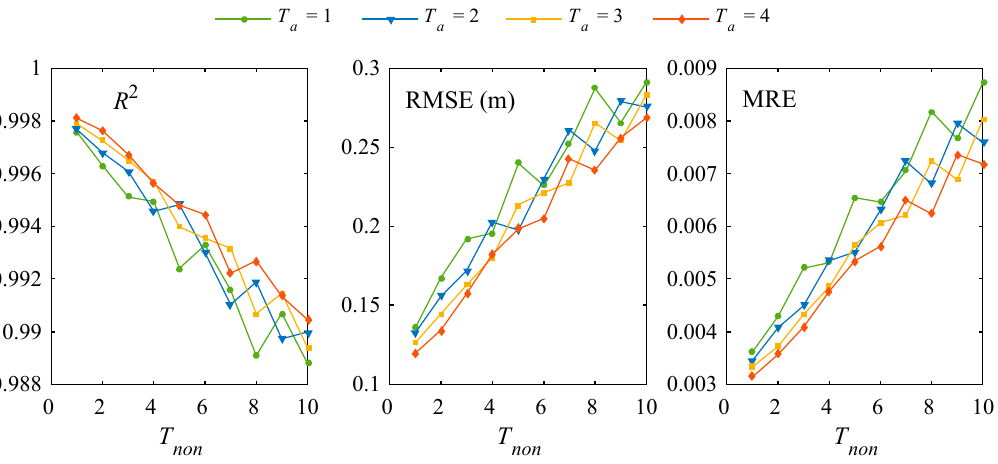
Figure 14. SVR+UKF performance under different assimilation/non-assimilation cycles at Yingtian.